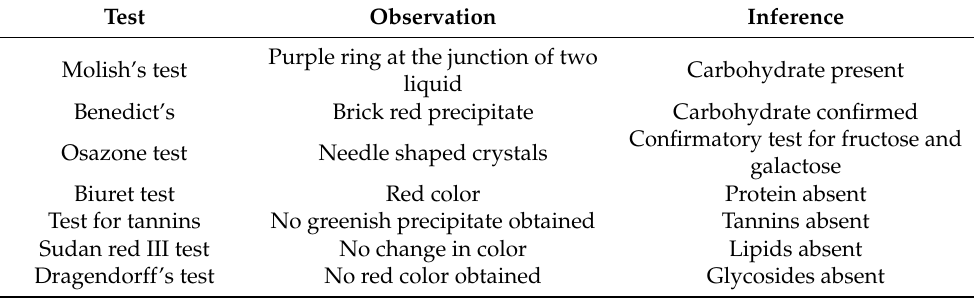
Table 1. Different chemical tests employed on